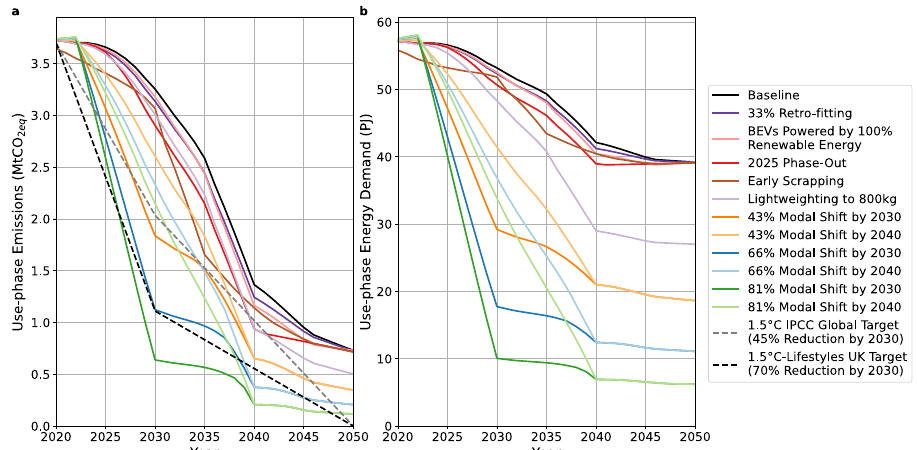
Fig.3|Theimpactofvariouspolicyoptionsonuse-phaseemissionsandenergy demand. The 2020 – 2050 London car annual CO 2 emissions ( a ) and energy demand ( b ) results are shown for the baseline case and different policy options appliedtothebaselinecase.Sixreductionsindistancedrivenareexplored,atthree magnitudes of 43%, 66% and 81%, representing the London goal, Paris goal and a